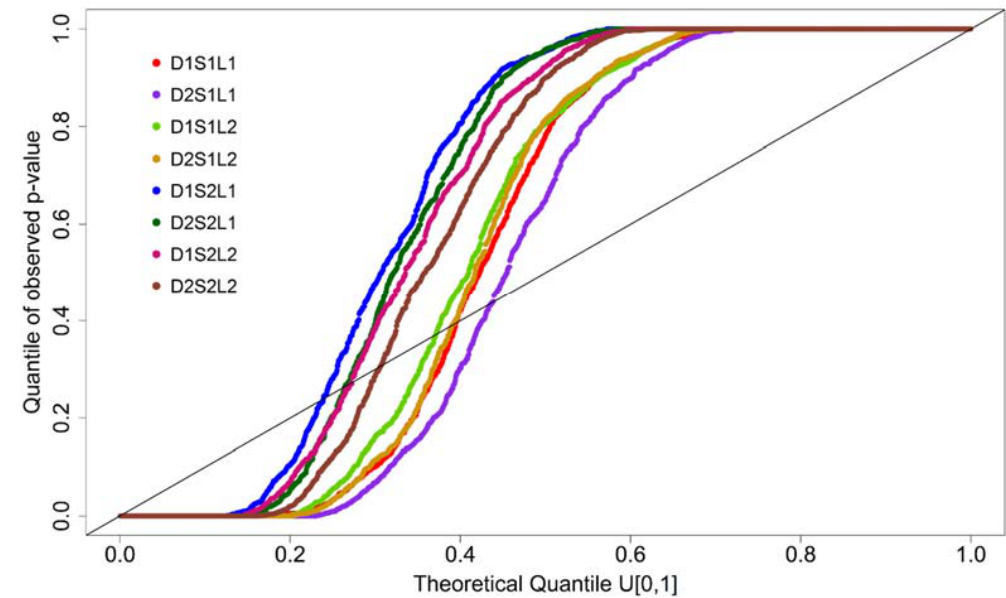
Figure 5. Predictive quantile–quantile (QQ) plots of the different best fit model SWAT setups derived from different input data (see Table 1).